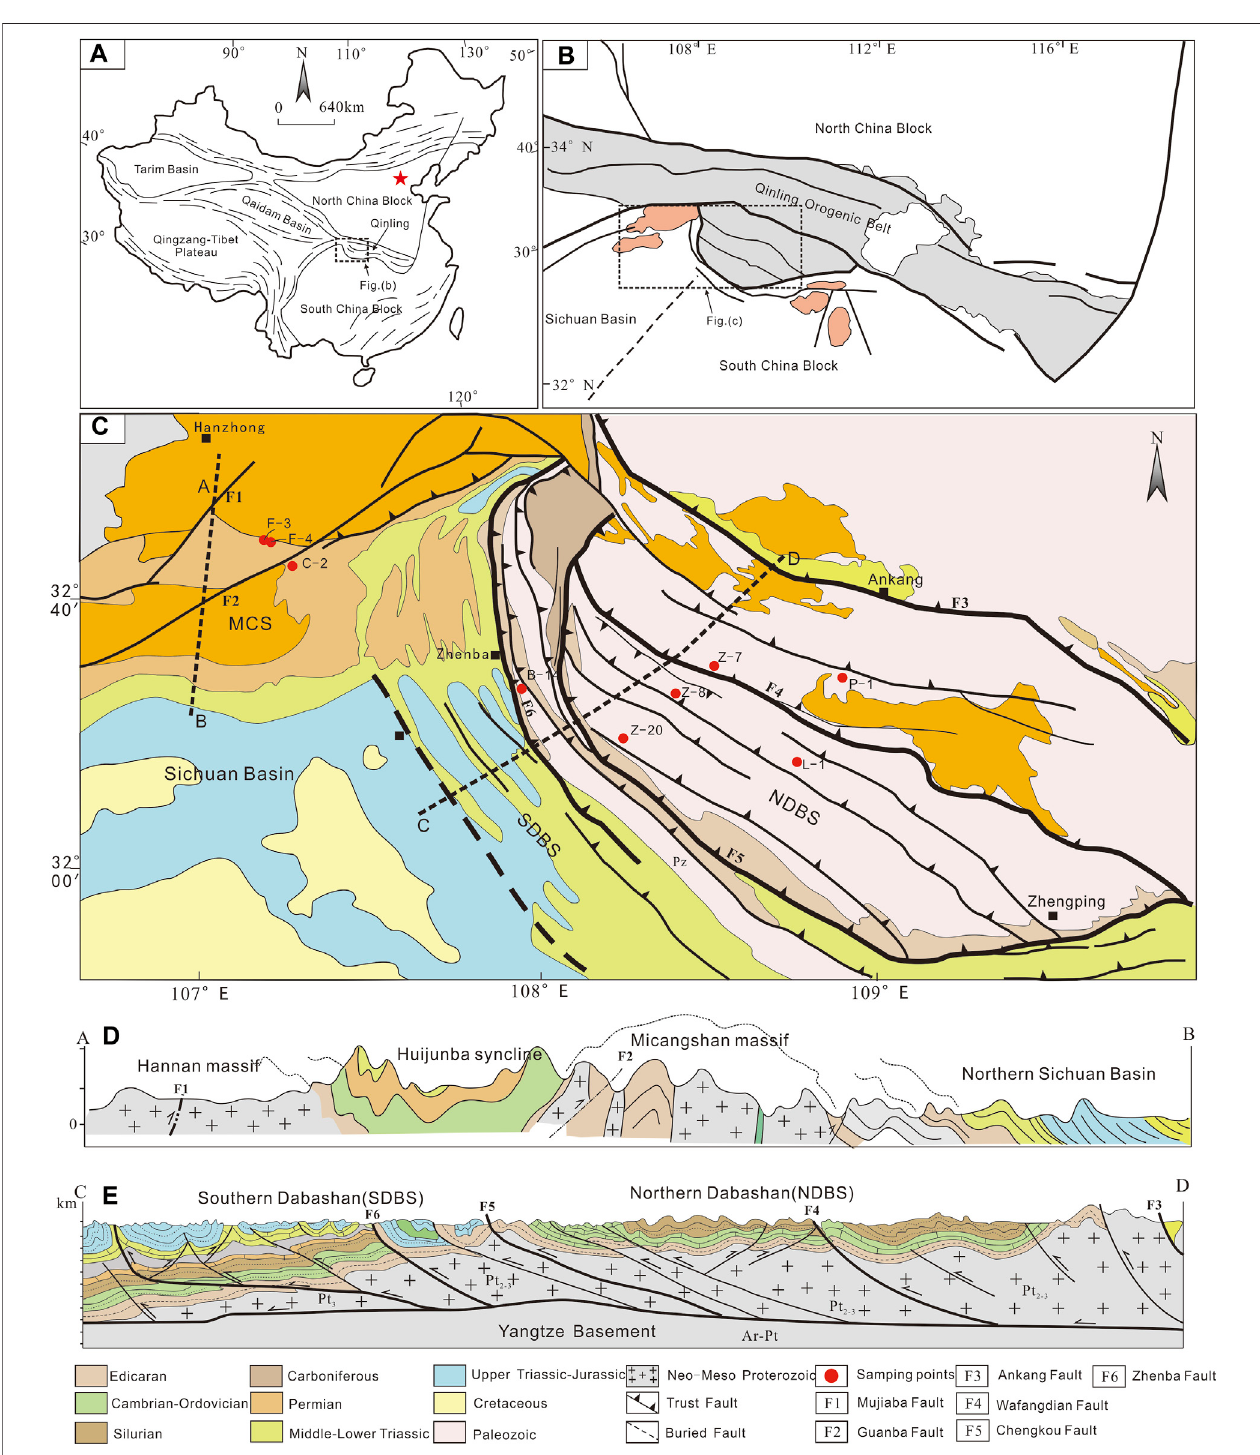
FIGURE 2 | Geological sketch map of the study area and sampling location. (A) The study area is located between the SCB and NCB in Central China (B) The Dabashan tectonic belt is on the southern margin of the Qinling Orogen. Micangshan is located between the Sichuan Basin and Qinling Orogen (C) Sample locations plotted on ageologic-tectonic map ofthe Micangshan and Dabashan tectonic belts. (D) , (E) Geologic cross-sections “ A-B ” and “ C-D ” , modi fi ed from Yang et al. (2013) and Shi et al. (2012).